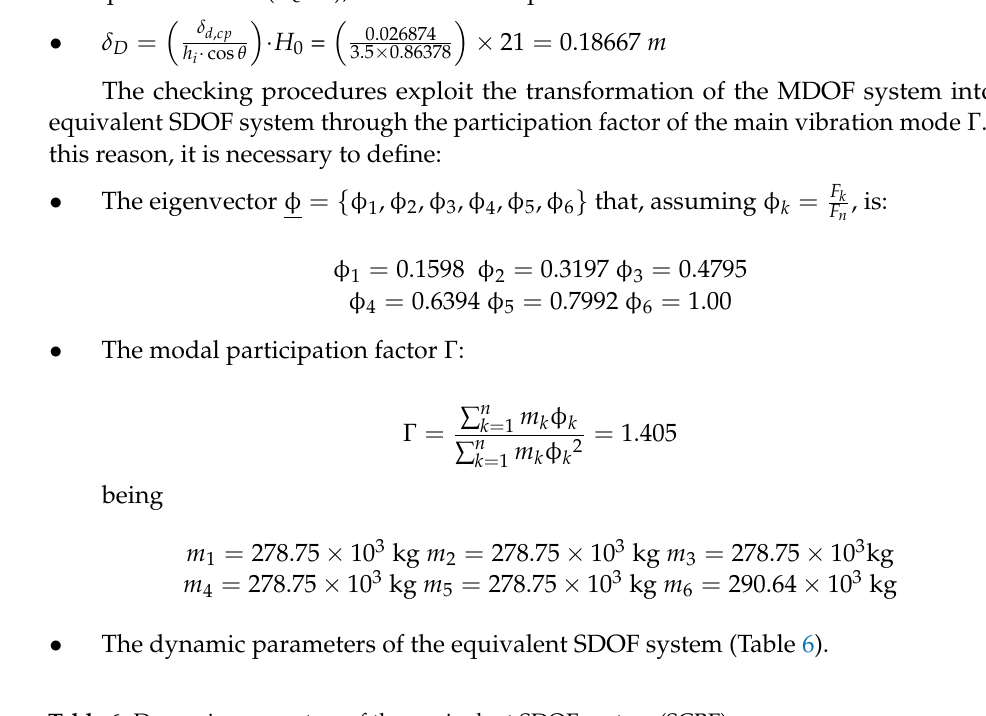
Table 6. Dynamic parameters of the equivalent SDOF system